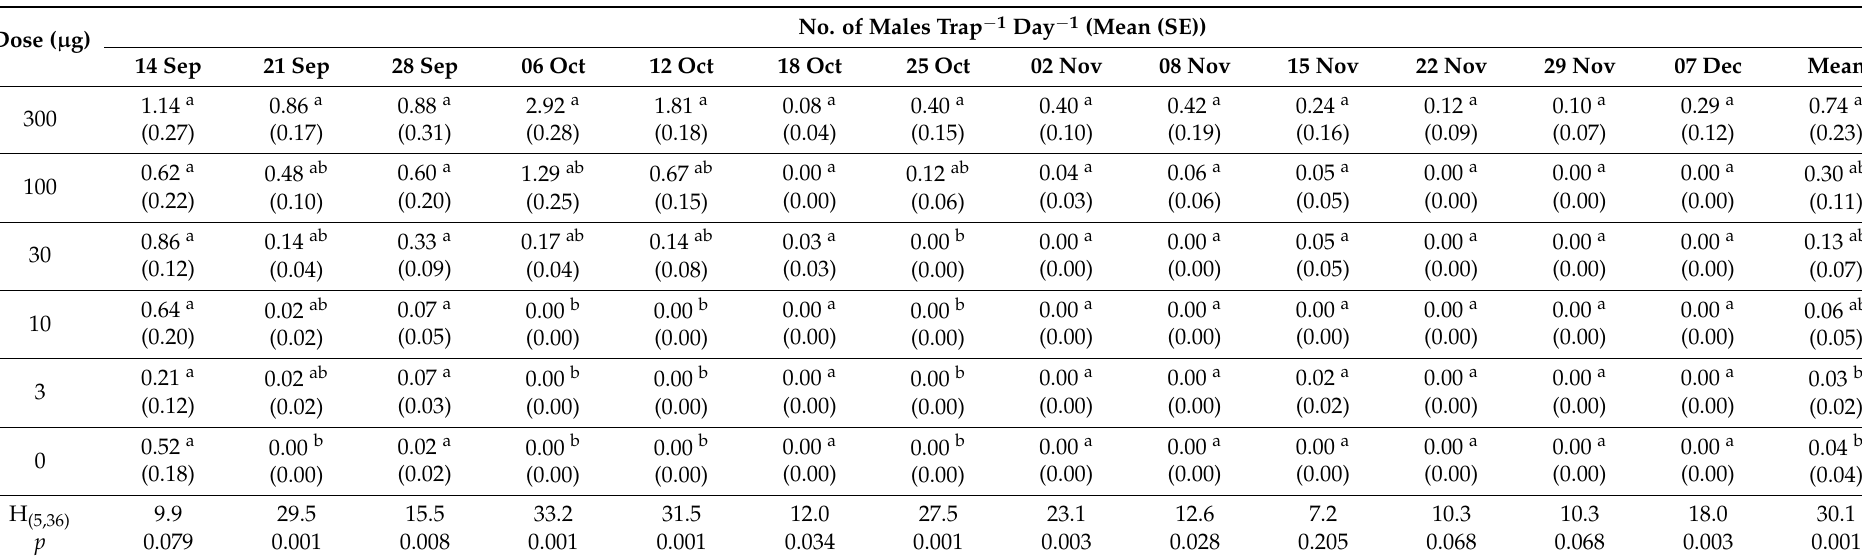
Table 4. Captures of male Chilecomadia valdiviana in traps baited with different doses of the main component Z7,Z10-16:Ald of the sexual pheromone in an apple orchard during 2016 in the Maule Region,